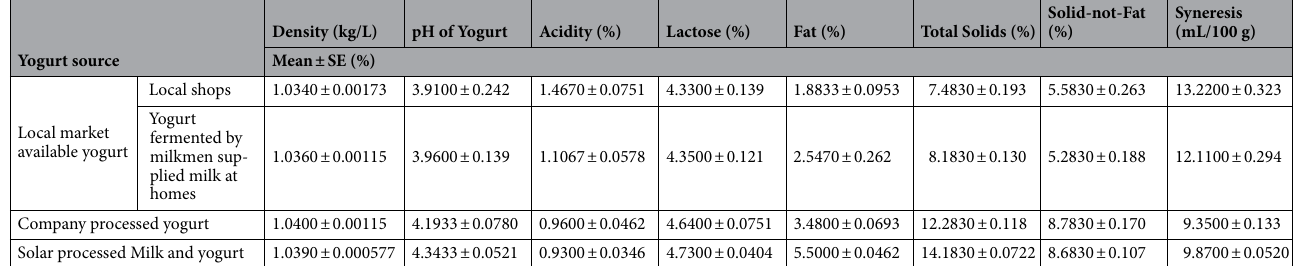
Table 3. Physical attributes of yogurt samples tested from local shops, milkmen, company-processed milk and solar-processed